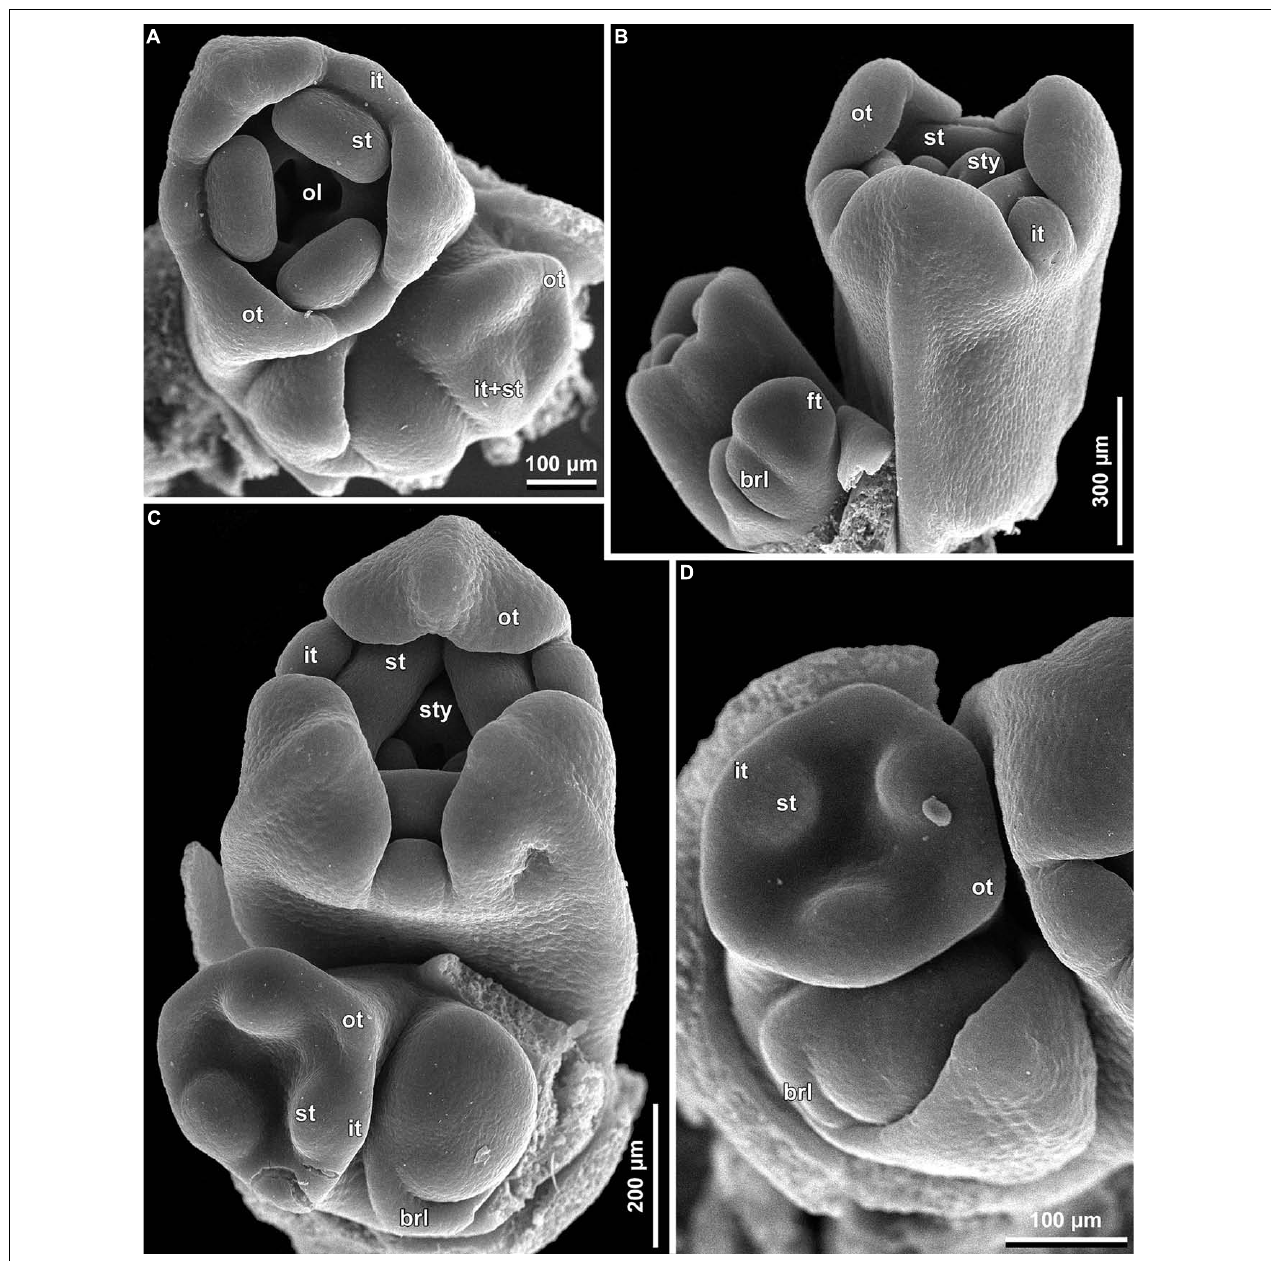
FIGURE 9 | Early floral development of Burmannia disticha (SEM): portions of cincinni in top (A,C,D) and side (B) views. brl, bracteole; ft, floral tube; it, inner tepal; ol, ovary locule; ot, outer tepal; st, stamen; sty, style.